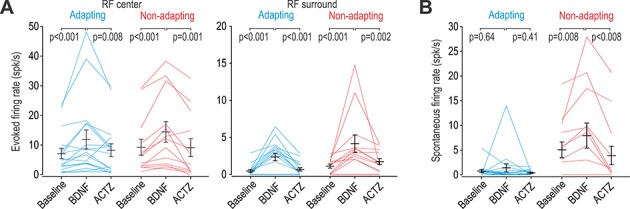
BDNF causes disinhibition in both adapting and non-adapting units.(A) Intrathecal BDNF (70 µg) and ACTZ (10 mM) had a significant effect on the firing evoked by brush stimulation of the RF center (F2,56 = 15.41, p<0.001; two-way repeated measures ANOVA) or surround (F2,56 = 17.92, p<0.001). BDNF significantly increased evoked firing and subsequent application of ACTZ significantly reduced firing in adapting (blue) and non-adapting (red) units. Results of SNK tests are reported on graphs. (B) BDNF and ACTZ also had a significant effect on spontaneous firing (F2,56 = 6.76, p=0.002; two-way repeated measures ANOVA) but that effect differed between cell types (interaction, F1,56 = 8.10, p=0.008). Only non-adapting units responded to BDNF with significantly increased spontaneous firing, which was entirely reversed by ACTZ. Results of SNK tests are reported on graphs.Figure 7—source data 1.Numerical values for data plotted in Figure 7.